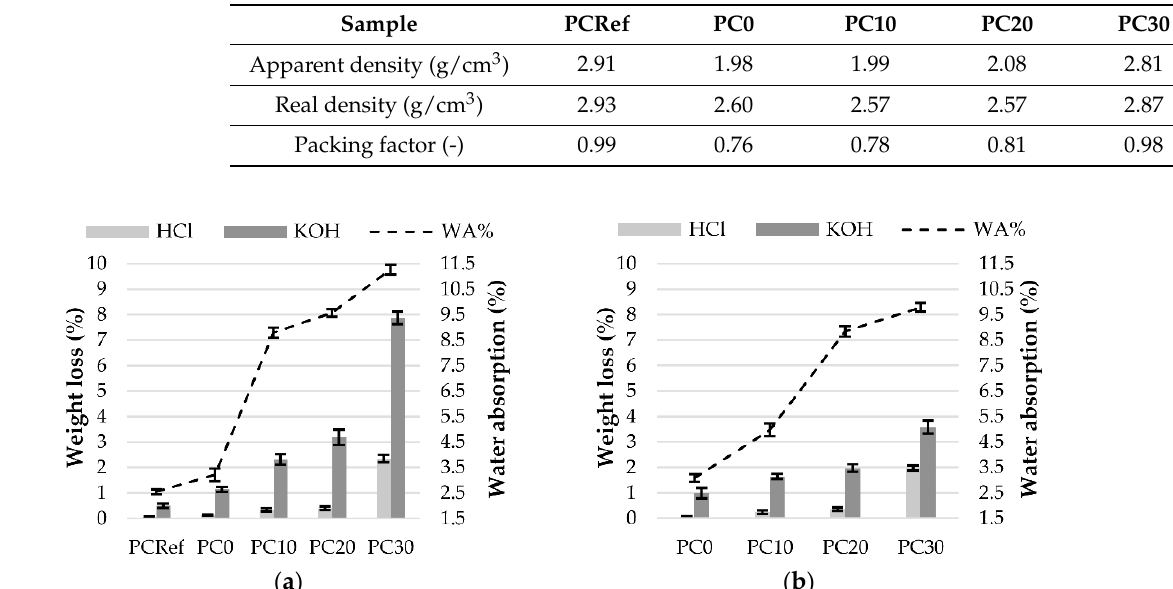
Figure 4. Correlation between chemical resistance (weight loss) and water absorption at increasing content of RGA fine fraction considering: ( a ) 1 wt% silane, ( b ) 4 wt% silane coupling agent. Error bars represent standard deviation.